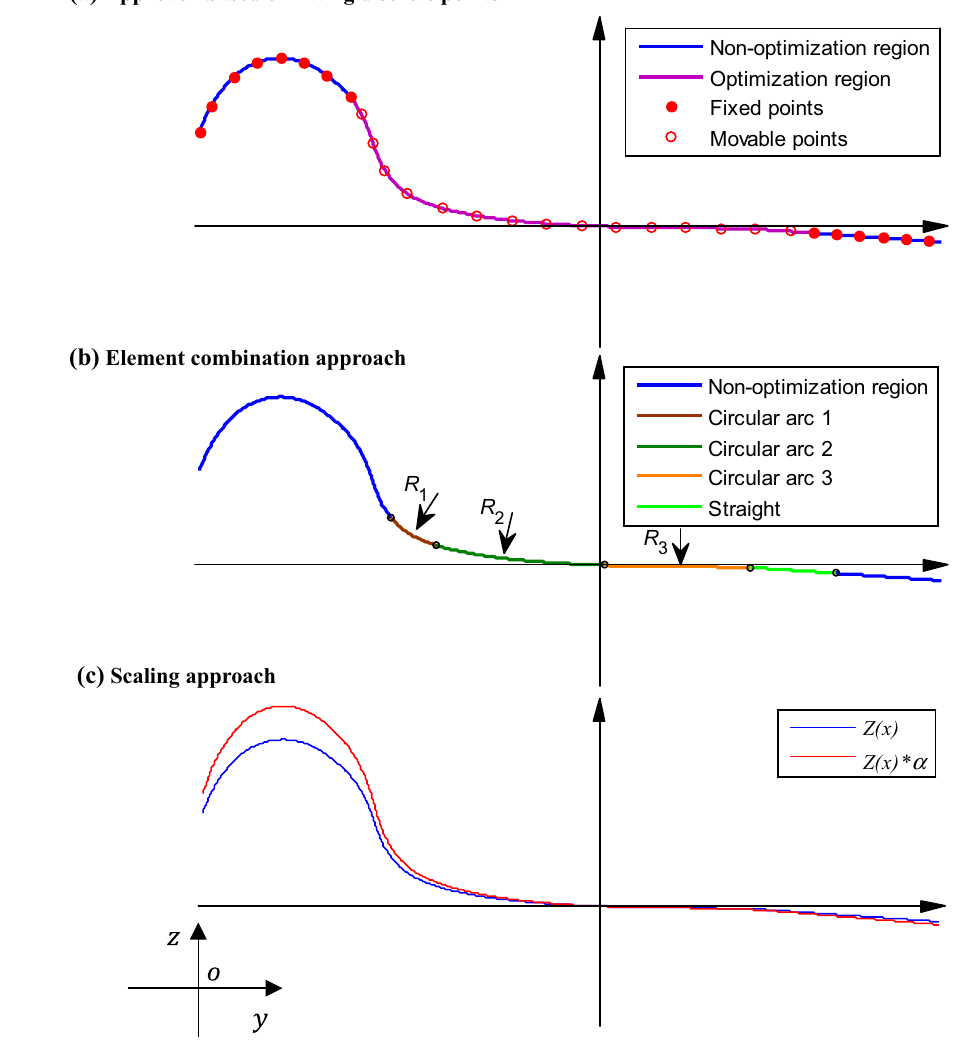
Fig. 5 Wheel profile generation